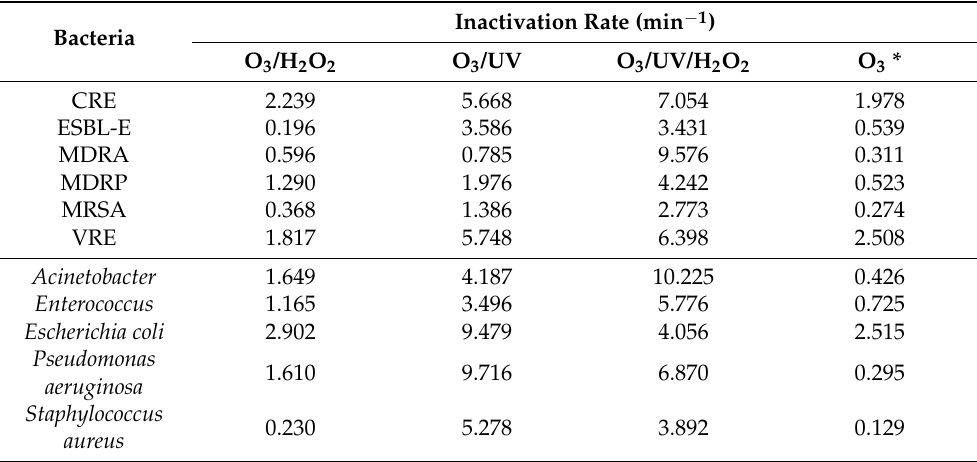
Table 2. Reaction rate constants for each AMRB and AMSB during O 3 -based AOP treatment for STP wastewater. (* Reported values from the previous research